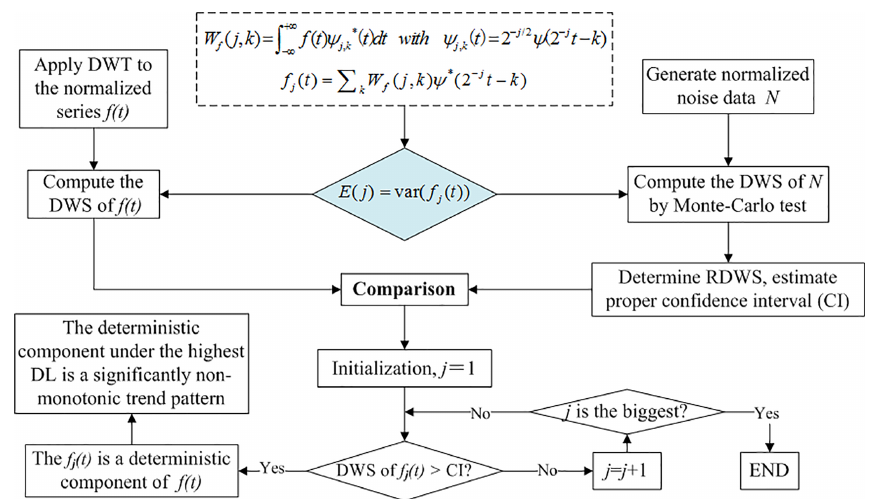
Figure 1. Technical flowchart for identification of the non-monotonic trends in a time series using the developed discrete wavelet spectrum (DWS) approach, where the discrete wavelet transform (DWT) method was used to decompose the time series and get sub-signal at each decomposition level (DL), and the reference discrete wavelet spectrum (RDWS) with certain confidence interval (CI) was used for the evaluation of